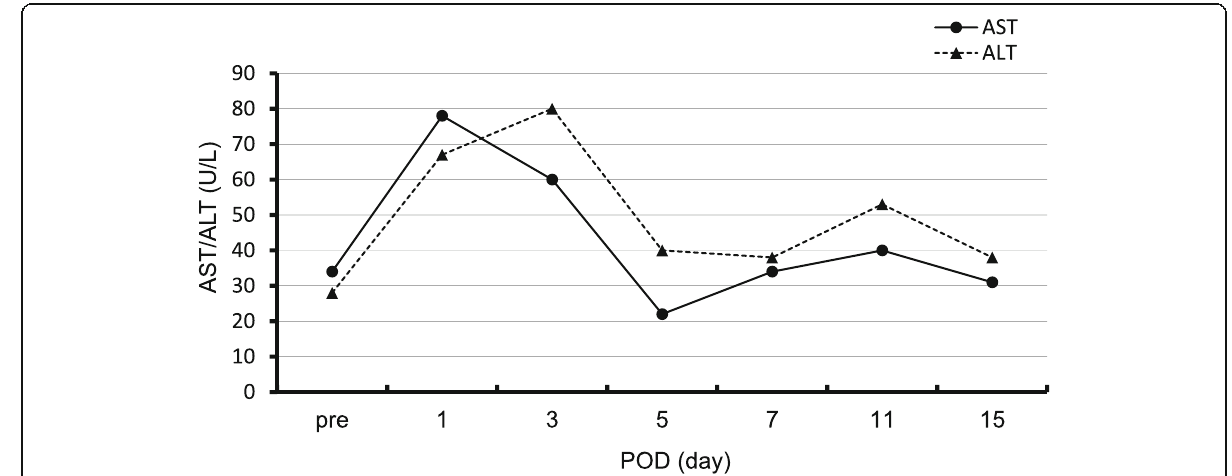
Fig. 6 Transition of hepatic enzymes in the pre and postoperative blood tests. There was only slight elevation of hepatic enzymes after the surgery. ALT, alanine aminotransferase; AST, aspartate aminotransferase